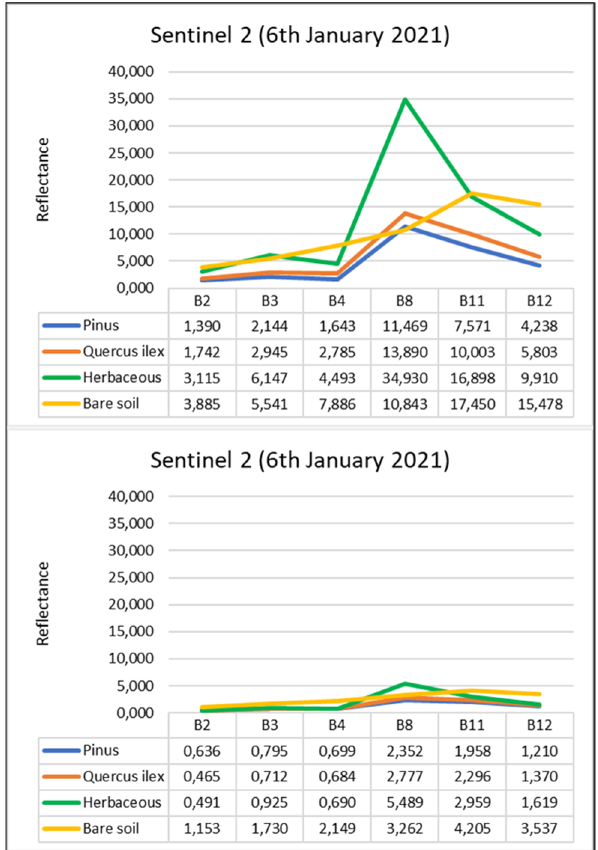
Figure 8. Differences in the spectral signatures (before and after the Storm Filomena) obtained from the bands of the Sentinel 2 satellite.